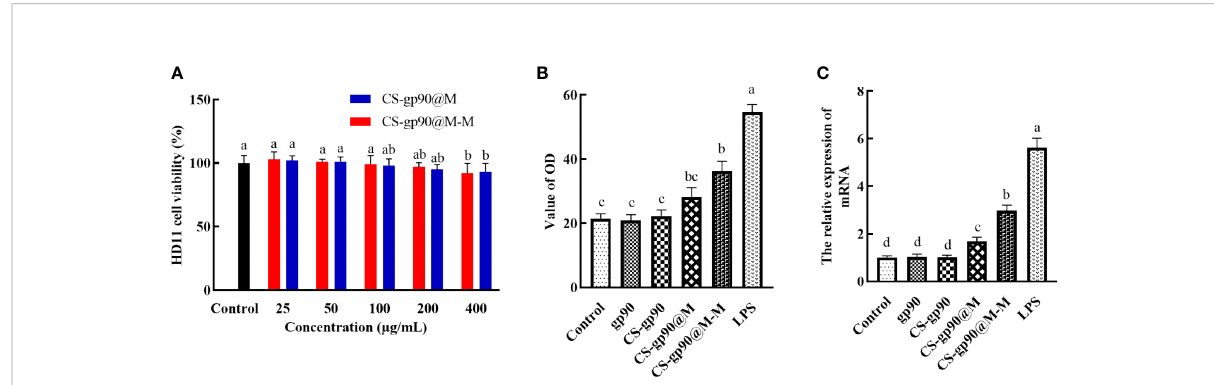
FIGURE 2 Toxicity and the immune-activating effect of CS-gp90@M-M nanoparticles on HD11 macrophages. (A) Effect of CS-gp90@M-M nanoparticles on macrophage viability, (B) NO release, and (C) iNOS mRNA levels. The different letters (a – d) designated as statistically signi fi cant differences ( P<0.05